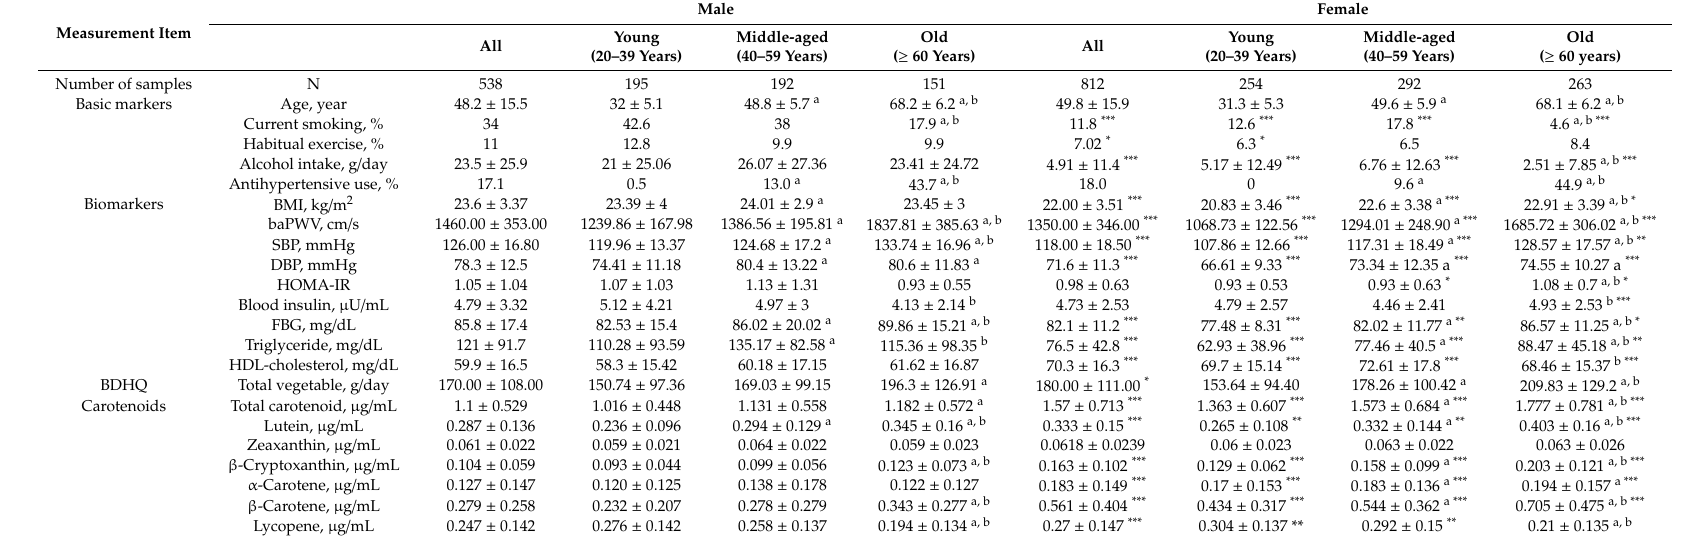
Table 1. Physiological characteristics of study